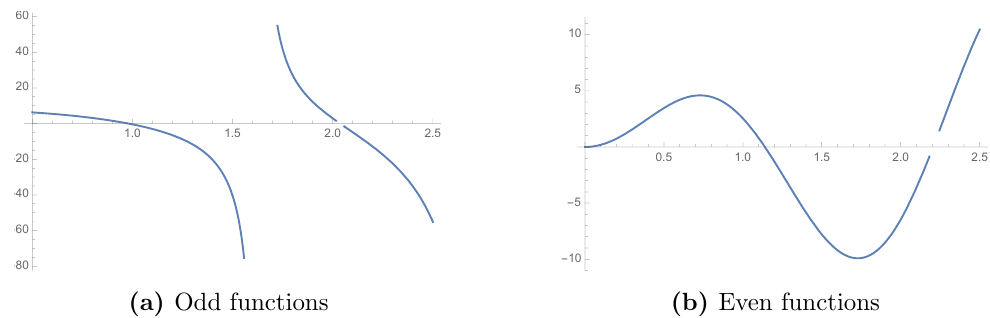
Figure 7. The Wronskian as a function of (cid:22) is depicted for odd or even functions. Its zeros (cid:22) = (cid:22) N give the spectrum of table